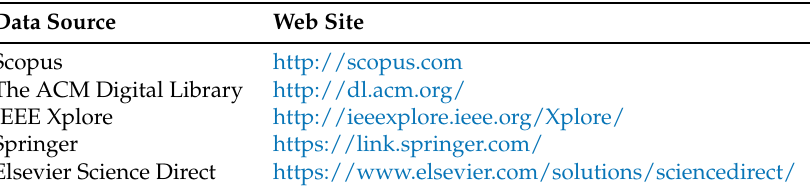
Table 2. Searched databases.